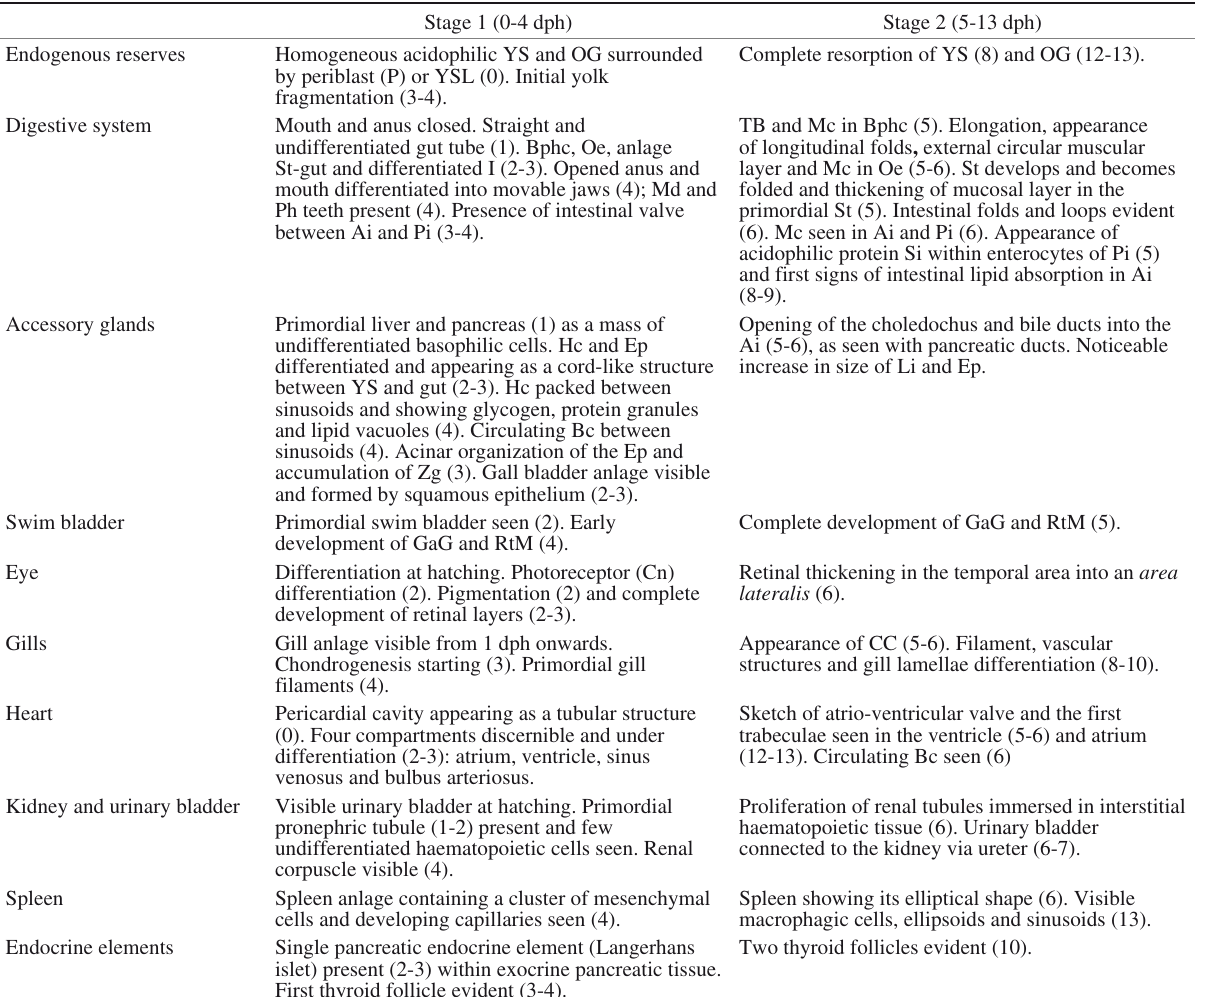
Fig. 2. – Oil globule and yolk sac reabsorption in Chelon labrosus larvae. Values are represented as mean ±S.E.M (n=25-30). Thin lines represent exponential regression plots. The equations were estimated taking into account individual larvae. Bar represents the time of mouth opening (4 days post-hatching, dph). Table 1. – Schematic synthesis of the main ontogenetic events occurring in Chelon labrosus larvae during the lecitotrophic (Stage 1) and endo- exogenous (Stage 2) phases. Numbers in brackets indicate the age in days post-hatching (dph) Ai, anterior intestine; Bc, blood cells; Bphc, bucopharyngeal cavity; CC, chloride cells; Ep, exocrine pancreas; GaG, gas gland; Hc, hepatocytes; I, intestine; Li, liver; Mc, mucous cells; Md, mandibular; Oe, oesophagus; OG, oil globule; P, periblast; Ph, pharyngeal; Pi, posterior intestine; RtM, rete mirabile ; Si,